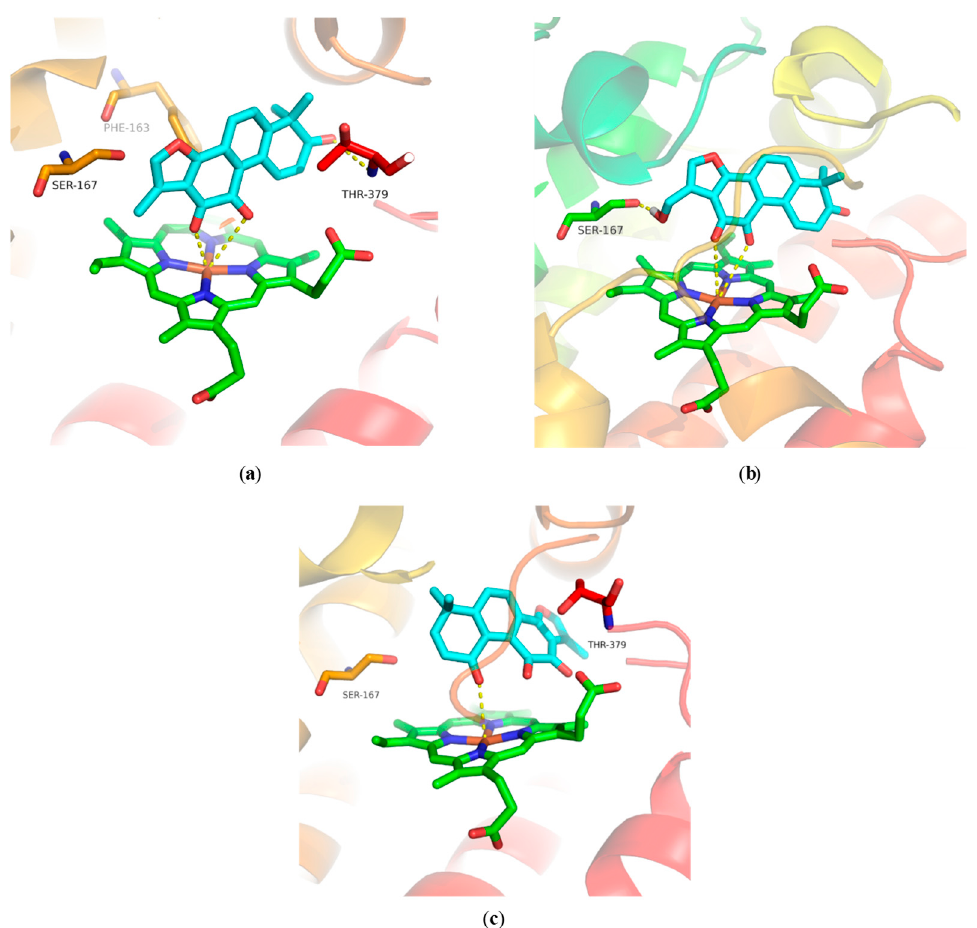
Figure 2. Docking models of compounds 11 , 12, and 14 bound to IDO-1. ( a ) Computational modeling at the active site of IDO-1 for 11 ; ( b ) computational modeling at the active site of IDO-1 for 12 ; ( c ) computational modeling at the active site of IDO-1 for 14 .